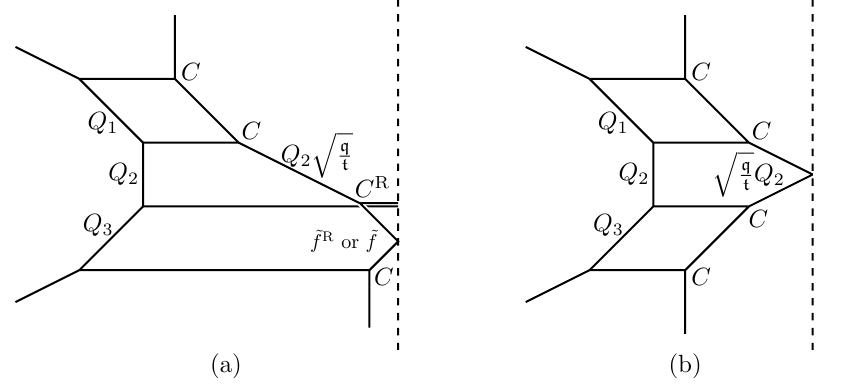
Figure 7 . Two 5-brane webs for D 2 (2 , 2) gauge theory which are related by a series of